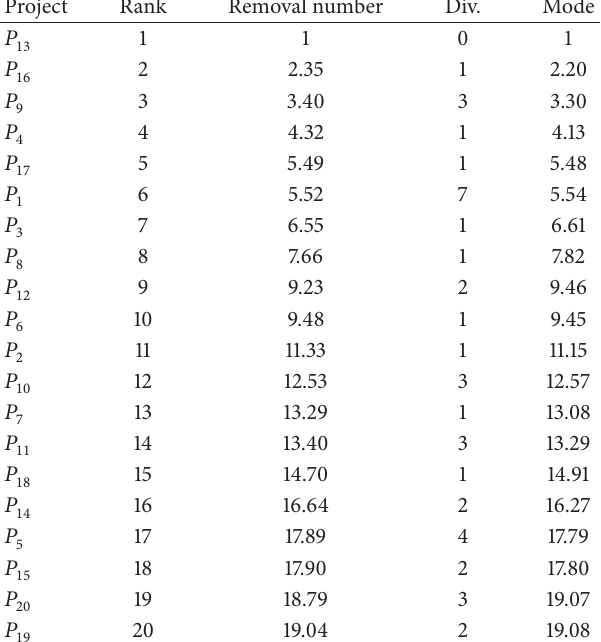
Table 5: Overall rankings of the R&D projects with De Luca and Termini entropy measure using removal number, dispersion, and modal value.